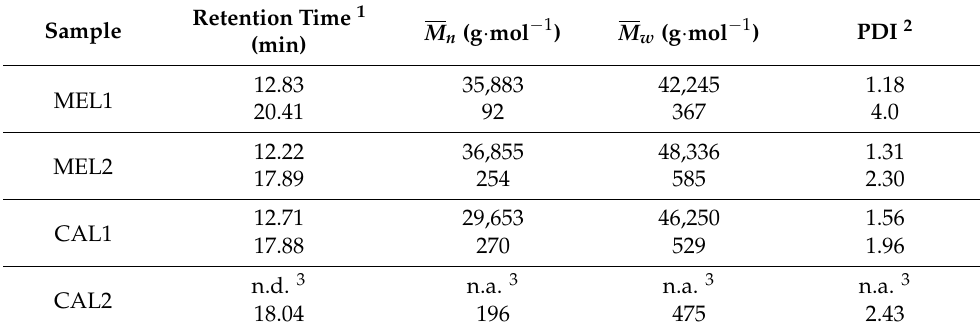
Table 4. SEC analysis of the DCM extractable fractions in the sediment samples.